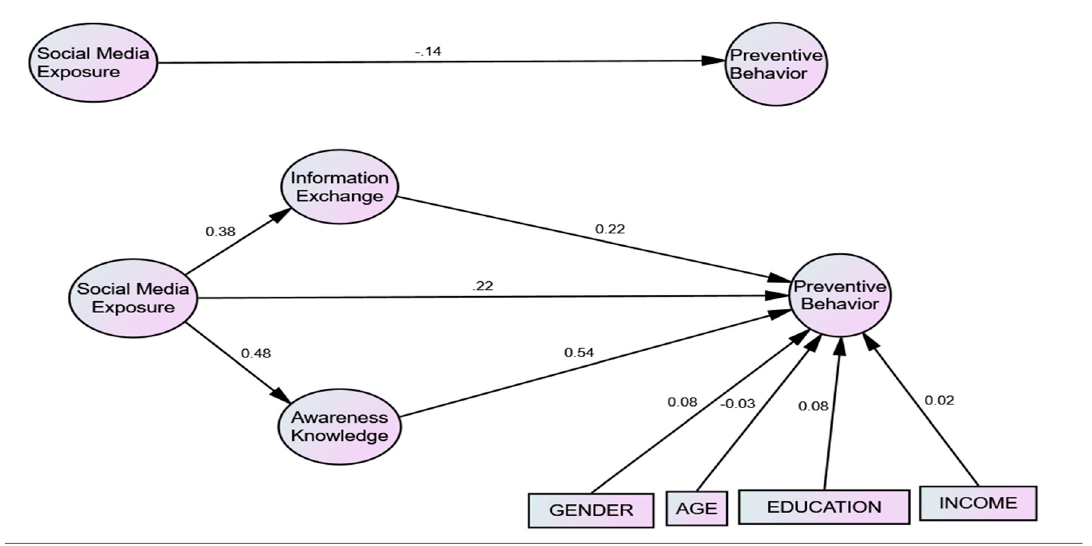
Figure 2. Mediating relationships.